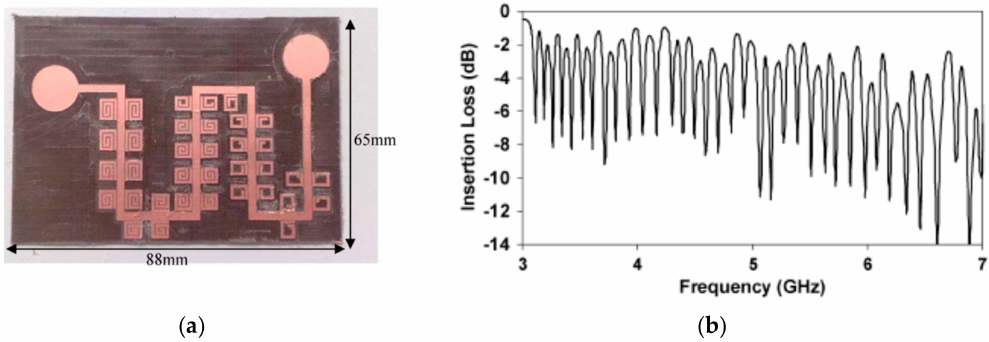
Figure 16. ( a ) Photograph and ( b ) measured response of a 35-bit tag implemented by Preradovic et al. Figure extracted from [56].